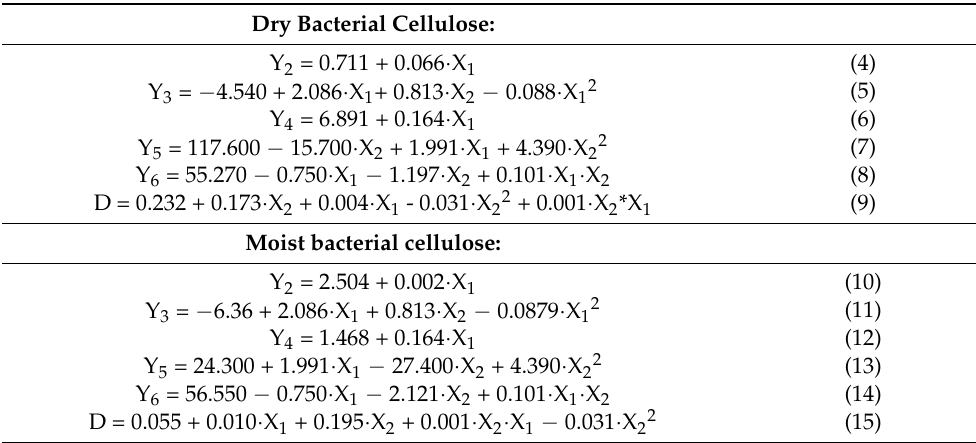
Table 4. The model equations in uncoded values of response variables for each of the 2 types of membranes (dry and